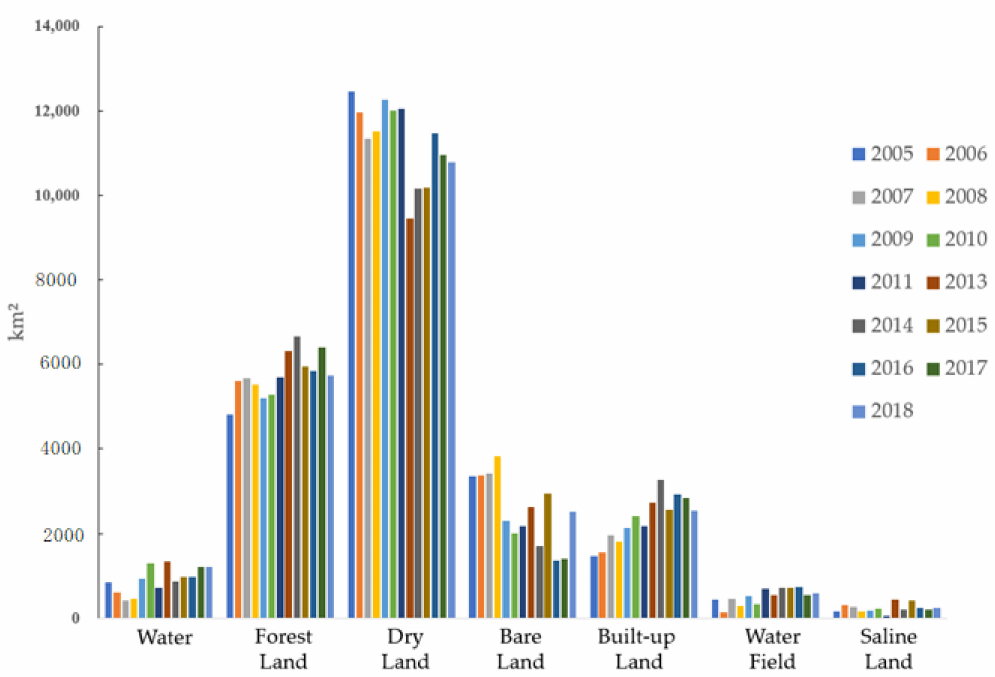
Figure 3. Land use type area map of the river basin buffer zone,